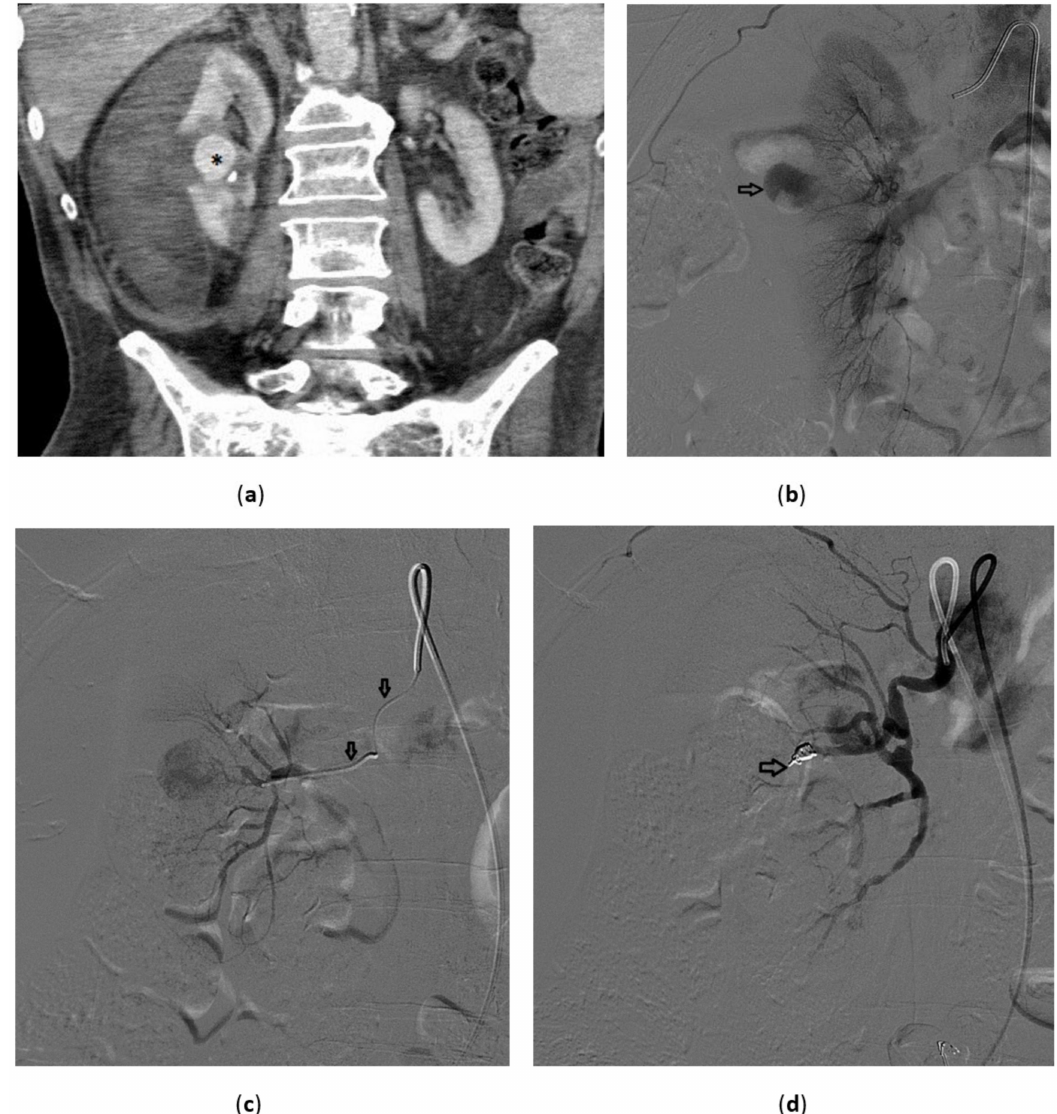
Figure 2. Renal pseudoaneurysm 79-year-old male with hematuria; previous attempt to insert a percutaneous nephrostomy on the right kidney. ( a ) Contrast enhanced CT: hyperdense round lesion (*) in the middle of the right kidney compatible with pseudoaneurysm with a large perirenal hematoma; ( b ) Right renal angiogram confirms the lesion (arrow). ( c ) A microcatheter was advanced in the feeding artery (arrows) and the visualization of the pseudoaneurysm after contrast media injection confirmed the correct position. ( d ) Two microcoils were deployed (arrow) and the pseudoaneurysm was no longer